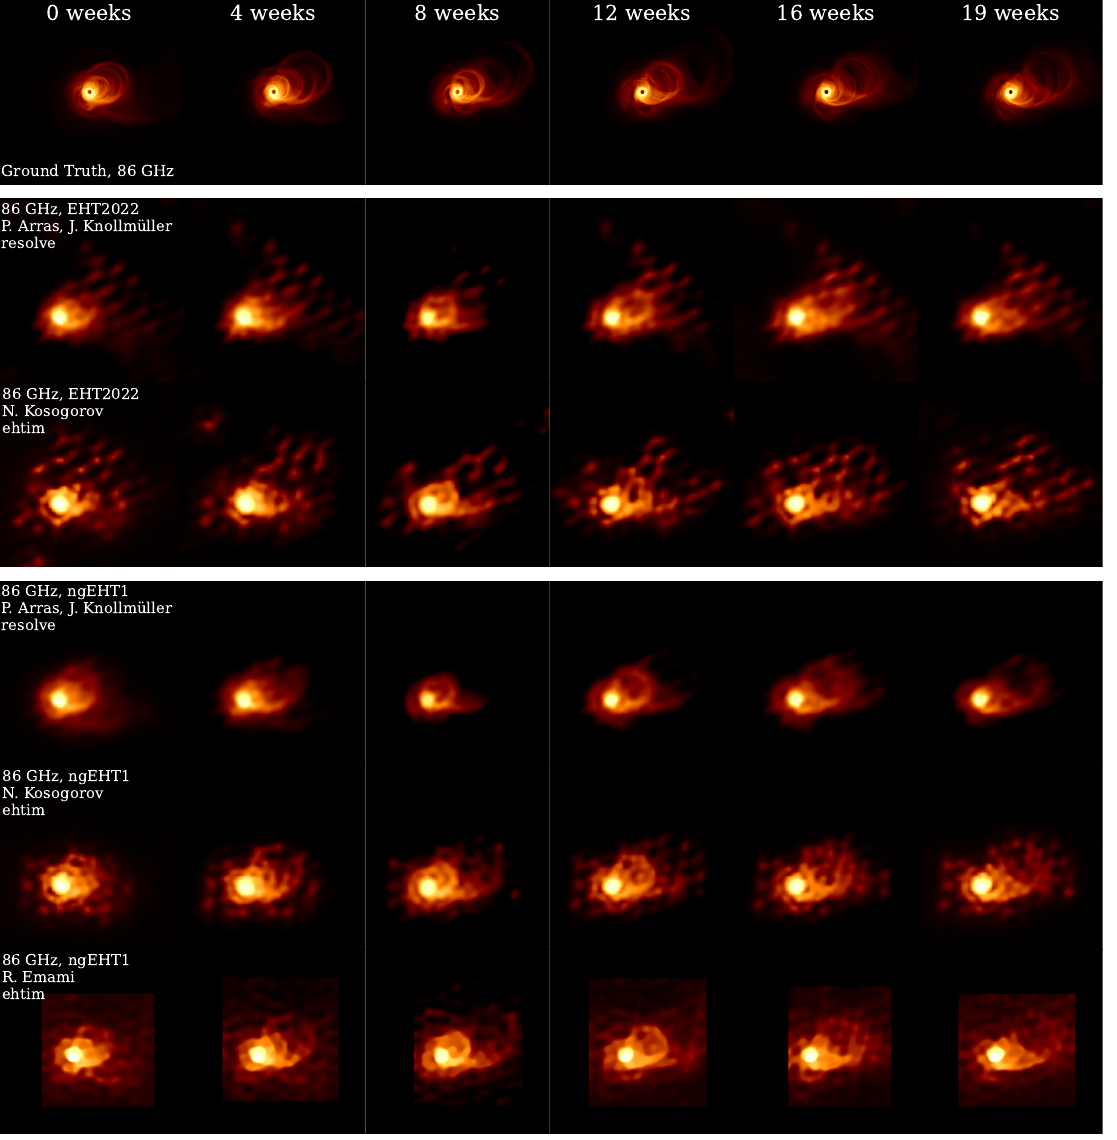
Figure 8. Selection of Challenge 2 M87 86 GHz submissions. Images are shown on a log scale, which is normalized to the brightest pixel value across each set of three movie frames, with a dynamic range of 10 3.5 and field of view of 1